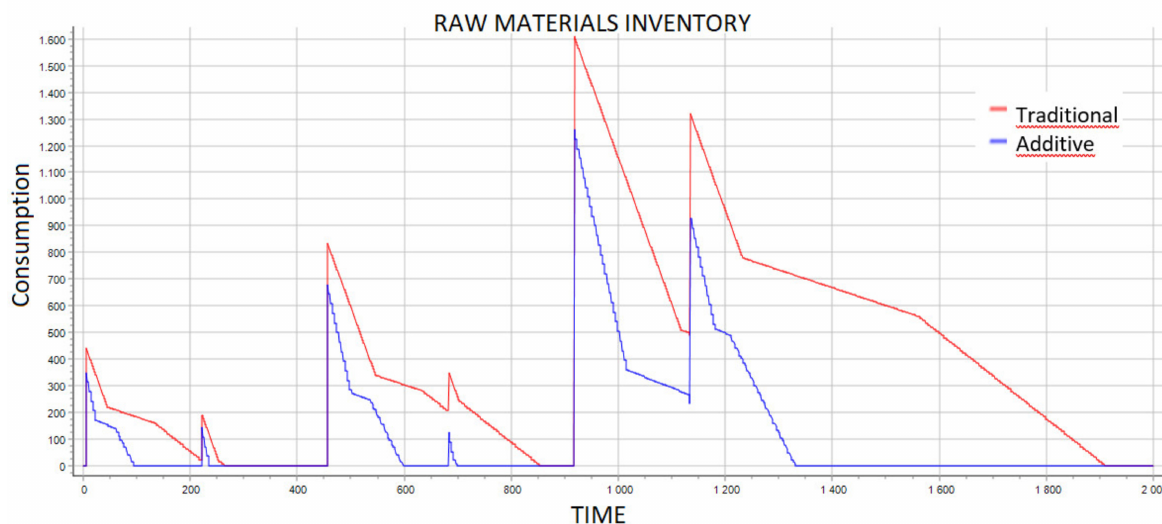
Figure 10. Raw material behavior. Source: own elaboration. Evolution